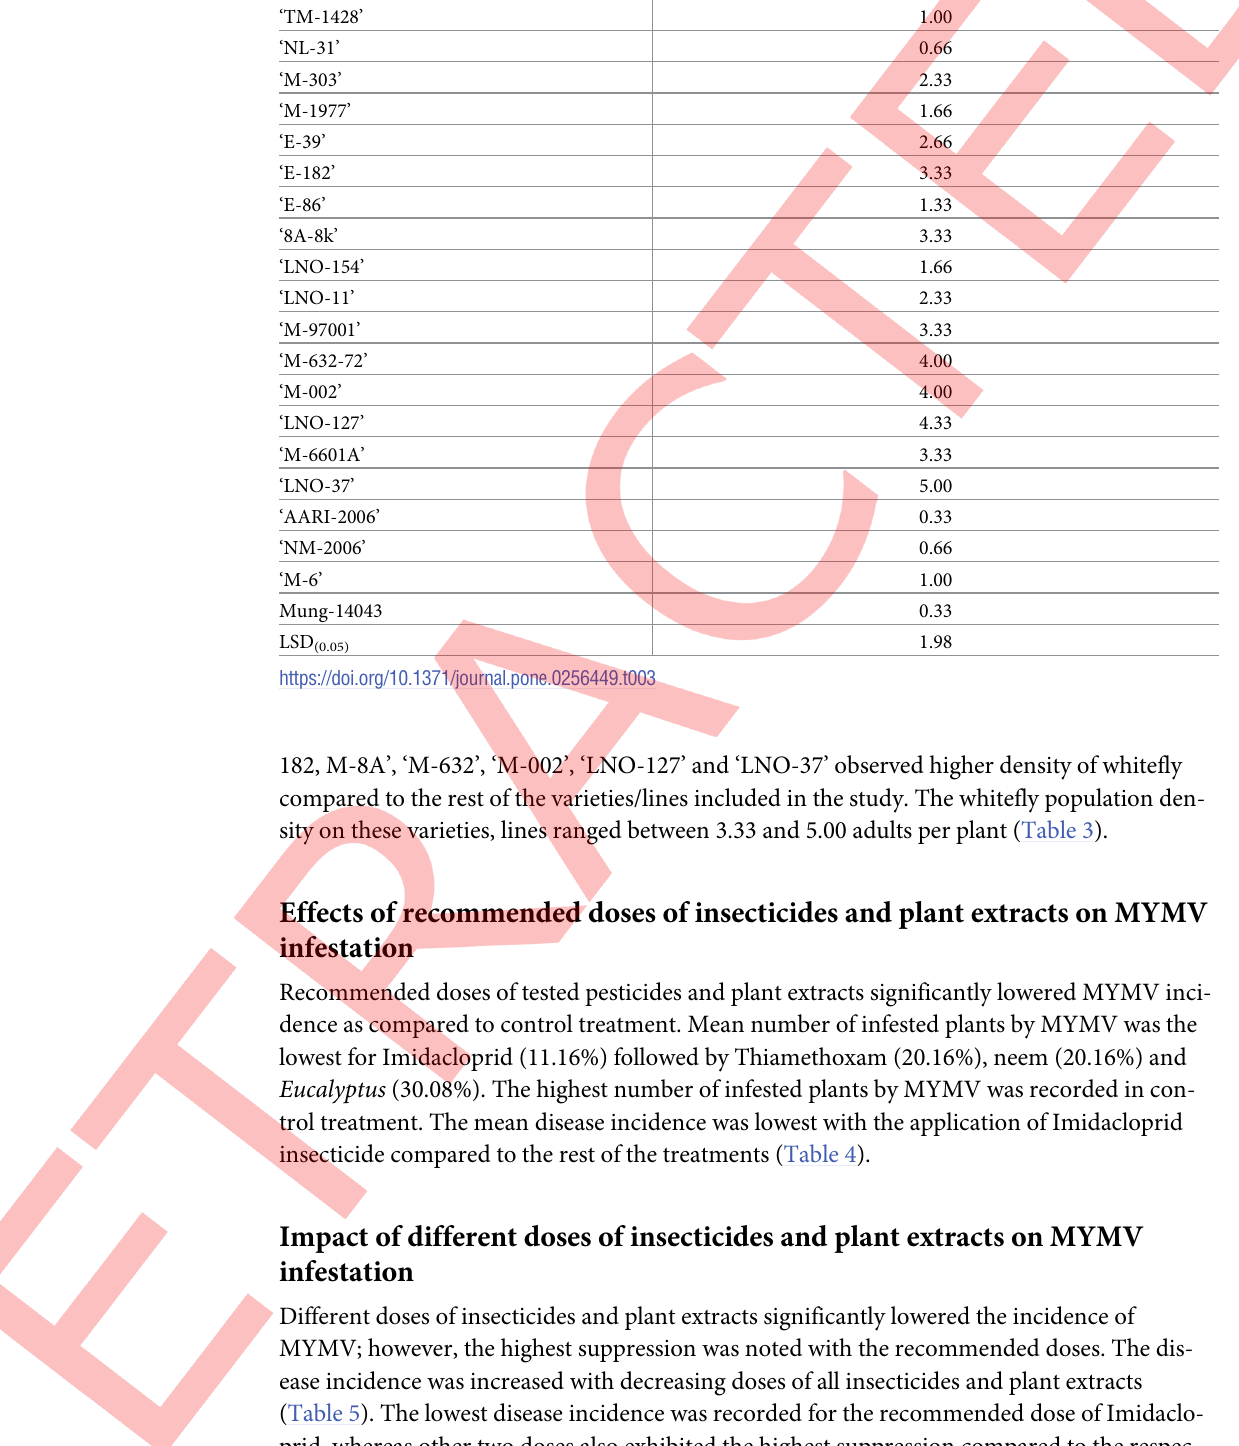
Table 3. The population density of whitefly on different mungbean varieties/lines included in the study.